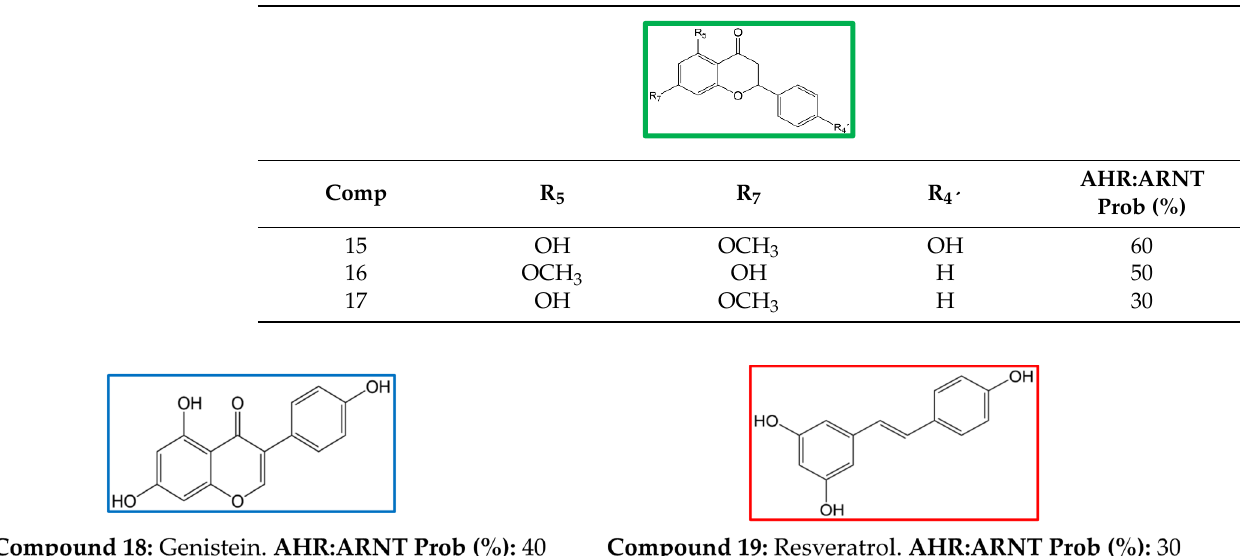
Figure 5. Genistein and resveratrol, with the probability of blockage.